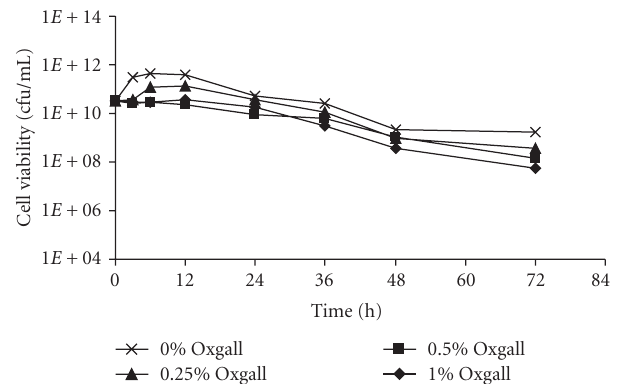
Figure 7: Adaptive response of microencapsulated L. plantarum 80 BSH + cells to bile stress in simulated intestine at bile concentrations of 0%, 0.25%, 0.50%, and 1.0%w/v, 37 ◦ C, and 100 RPM agitation. Pancreatin (0.18g/L) and sodium bicarbonate (2.4g/L) concentra- tions were kept constant.